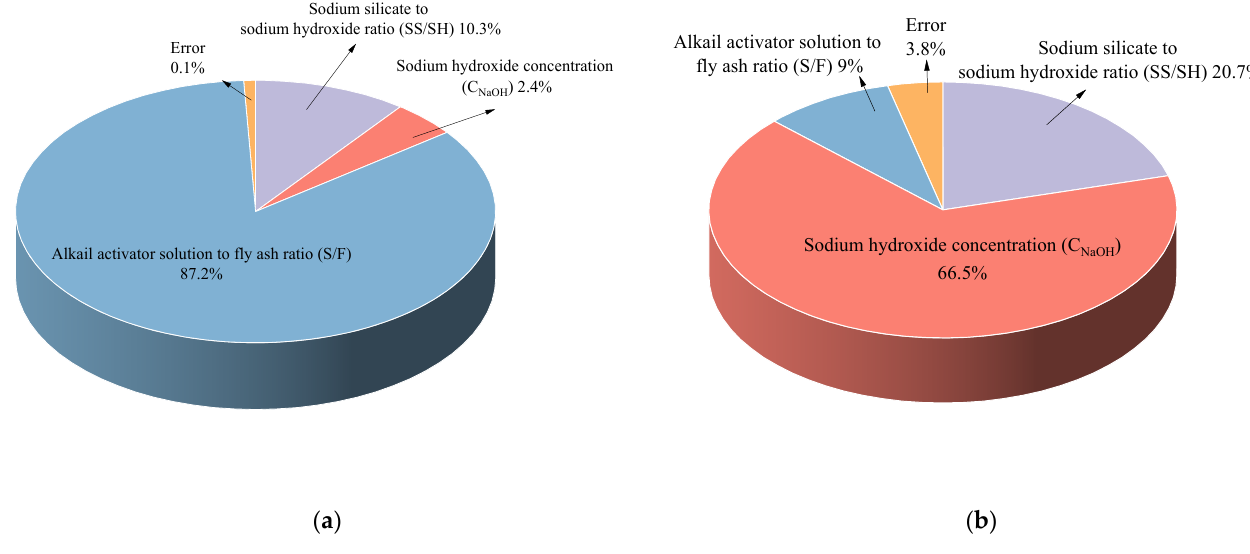
Figure 4. Percentage contribution of the impact factors of results: ( a ) CO 2 emission; ( b ) Compres